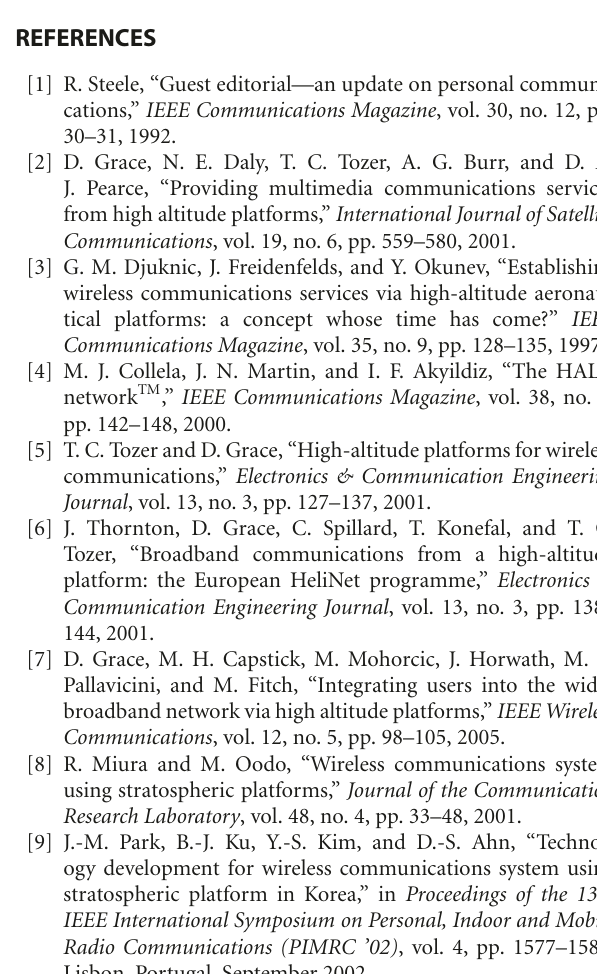
Figure 6: The other-to-own interference ratio obtained for a 30 km cell radius for (a) the performance of the voice service (12 kbps) from one HAP in combination with the data service (144kbps) on the remaining HAPs and (b) the performance when we have voice services (12kbps) on all HAPs. The distance on the ground d m is varied from 0 to 70 km.